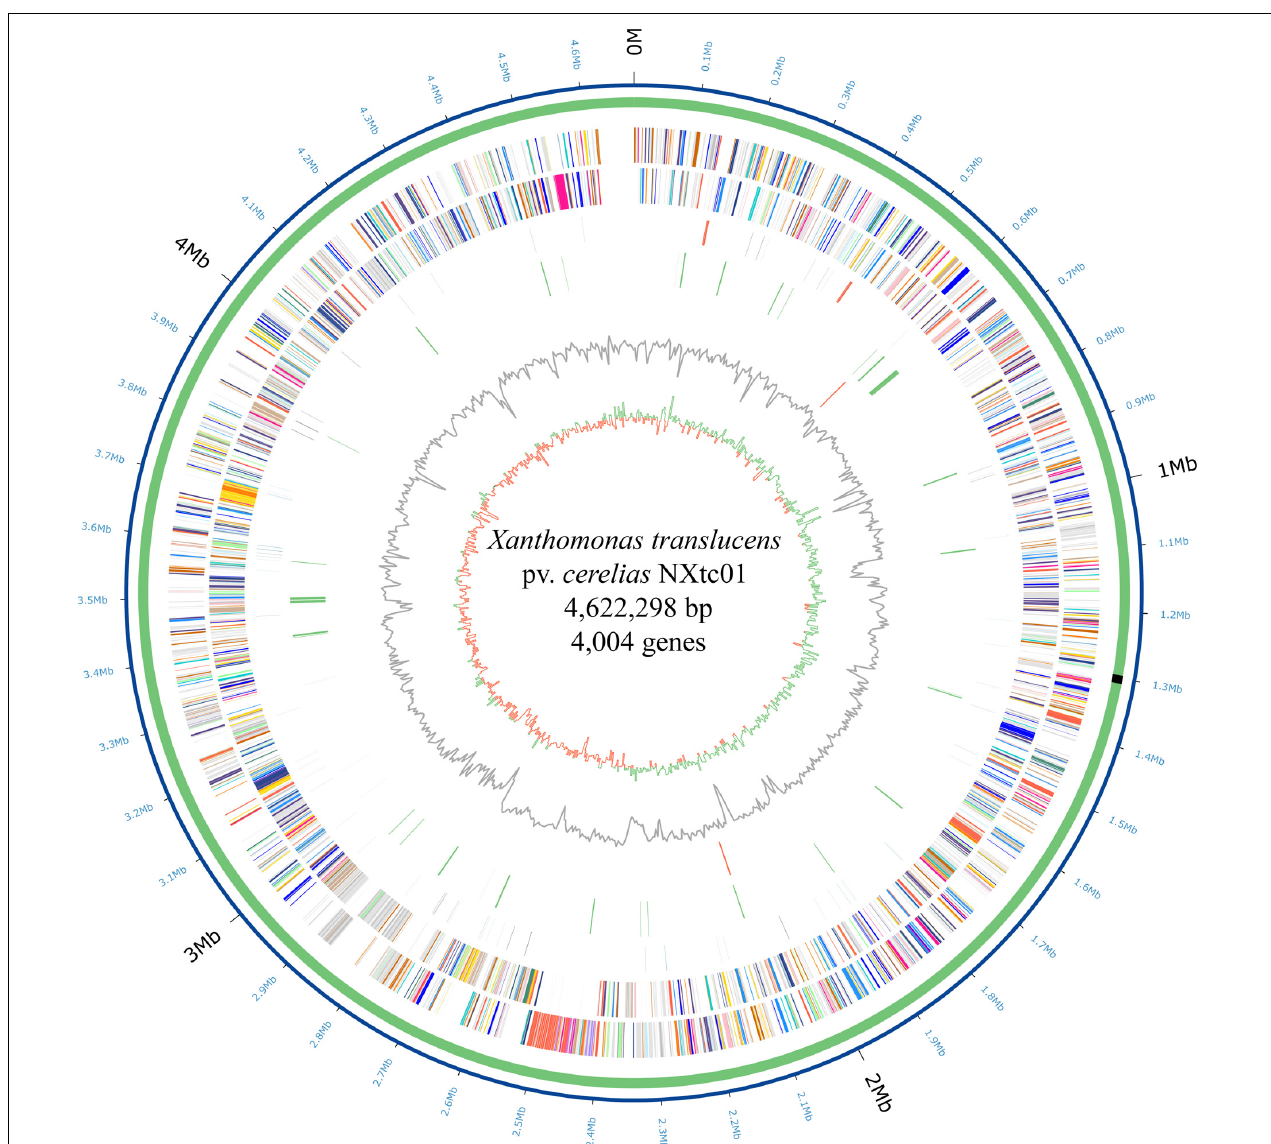
FIGURE 1 | Circular representation of the X. translucens pv. cerealis strain NXtc01 genome starting from gyrB . Inner to outermost rings illustrate GC skew (G − C)/(G + C), GC contents, tal genes (orange), IS elements (green), tRNA (blue), rRNA (orange) and ncRNA (black) genes, reverse COGs (cluster of orthologous groups), forward COGs ( Supplementary Table S4 ), chromosome (green), and coordinates (Mb). The T3SS genes cluster is indicated as black rectangle on